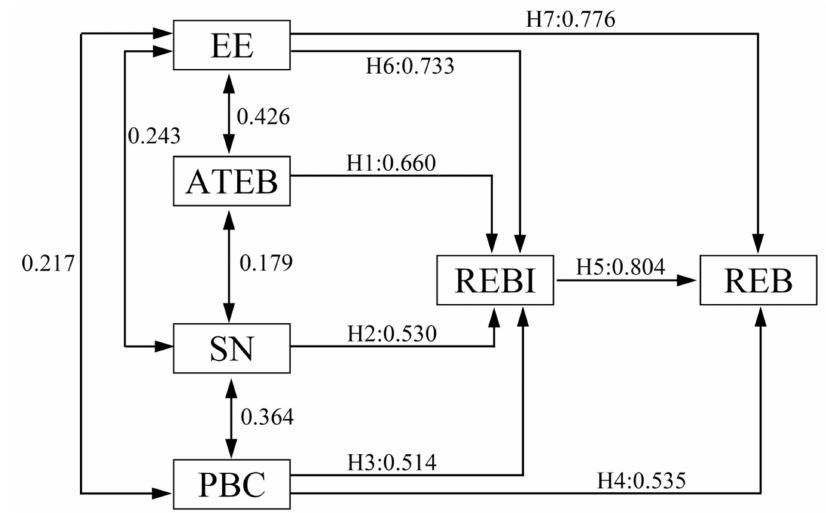
Figure 5. Results of the structural equation model. Attitudes toward environmental behaviors (ATEB), responsible environmental behaviors (REB), responsible environmental behavioral intentions (REBI), situational environmental education (EE), perceptual behavior control (PBC), and subjective norm